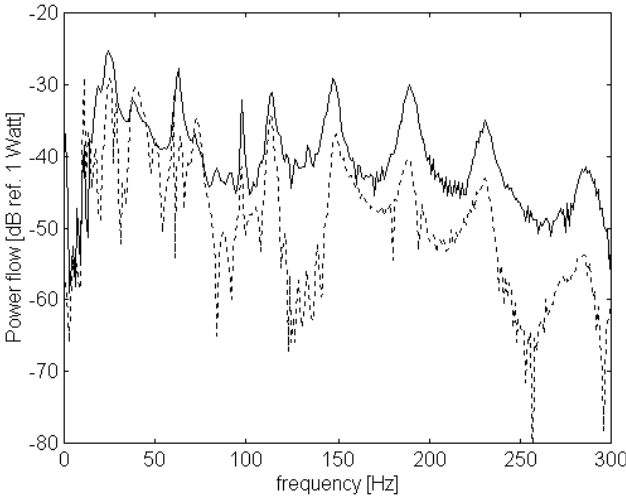
Fig. 3. Input power versus active SI measured with PVDF patches. — Input power; ··· active